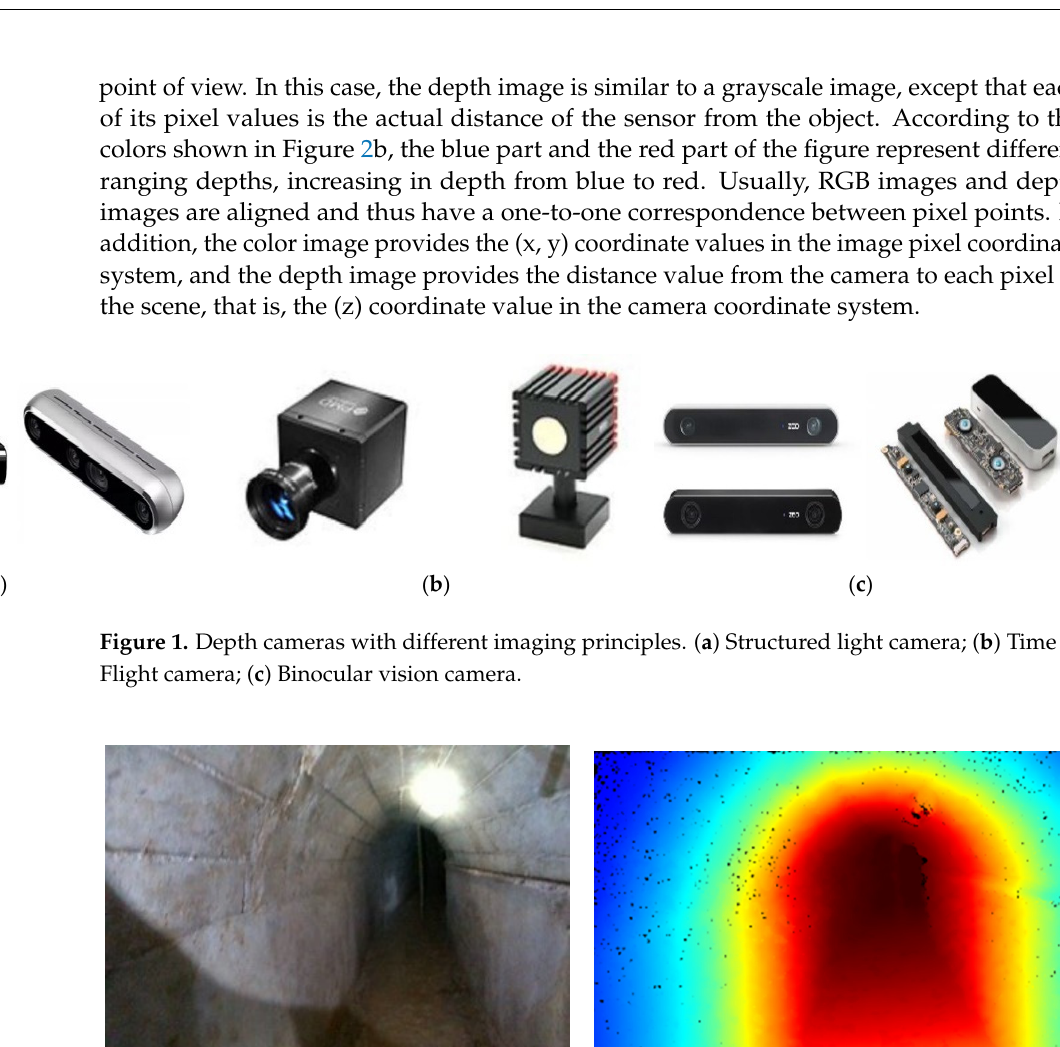
Figure 1. Depth cameras with different imaging principles. ( a ) Structured light camera ;( b ) Time of Flight camera; ( c ) Binocular vision camera.